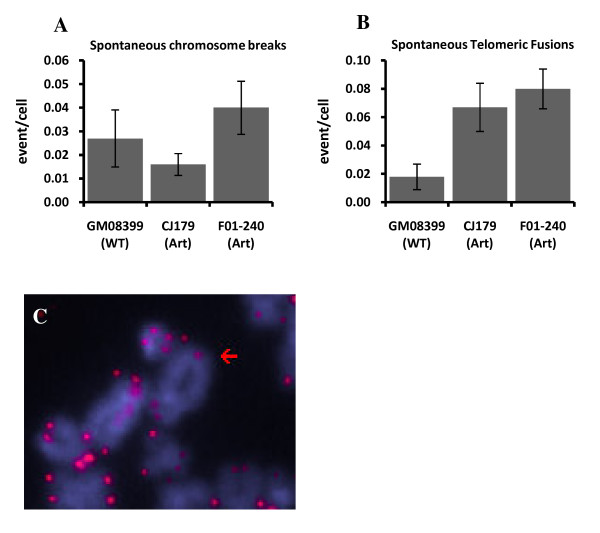
Spontaneous chromosome abnormalities in Artemis defective cells. A. Chromosome breaks. B. Telomeric fusions. C. Example of a telomeric fusion in a CJ179 cell: sister chromatid union. Error bars represent standard deviation (SD). Frequencies of abnormalities per cell were calculated from three separate experiments. The total number of metaphase cells analysed were: GM08399 - 111, CJ179 - 193 and F01-240 - 174.